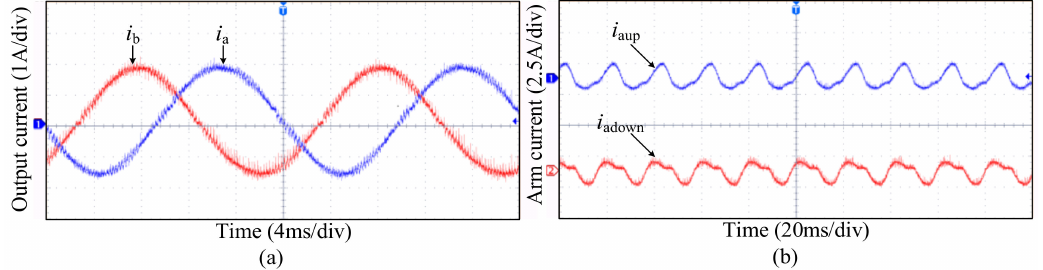
Figure 16. The currents in normal operation. ( a ) Output current; ( b ) Arm